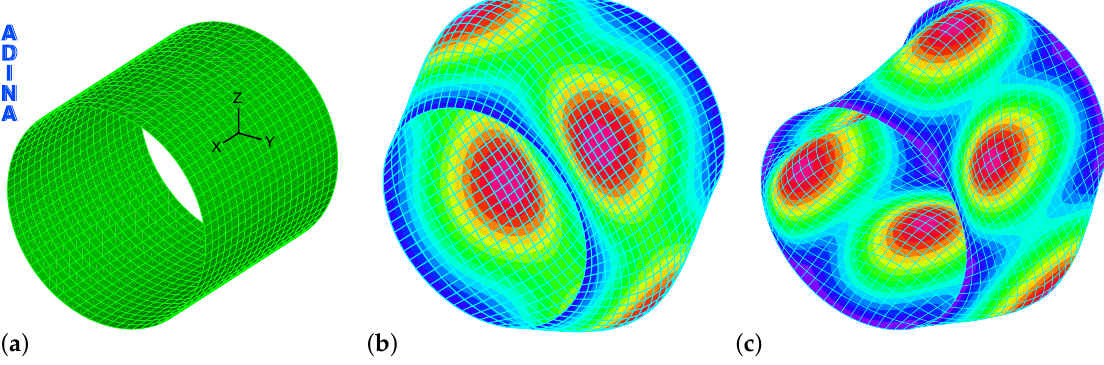
Figure 4. MODEL3: Finite element model ( a ) and the fundamental mode shape obtained either for constant lamination angles [ 90 16 ] s ( b ) or for Koide and Luersen’s optimal solution [ 90 2 / ± 45 11 /0/90/ ± 45 ] s ( c